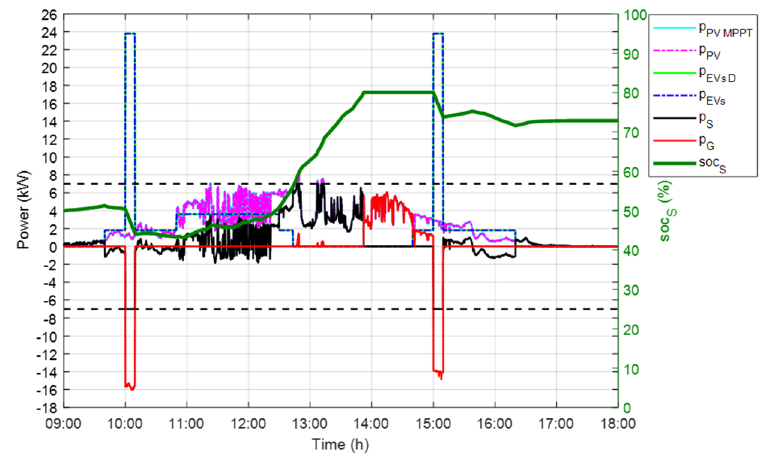
Figure 19. Scenario 2c, system power flows and stationary storage SOC evolution.